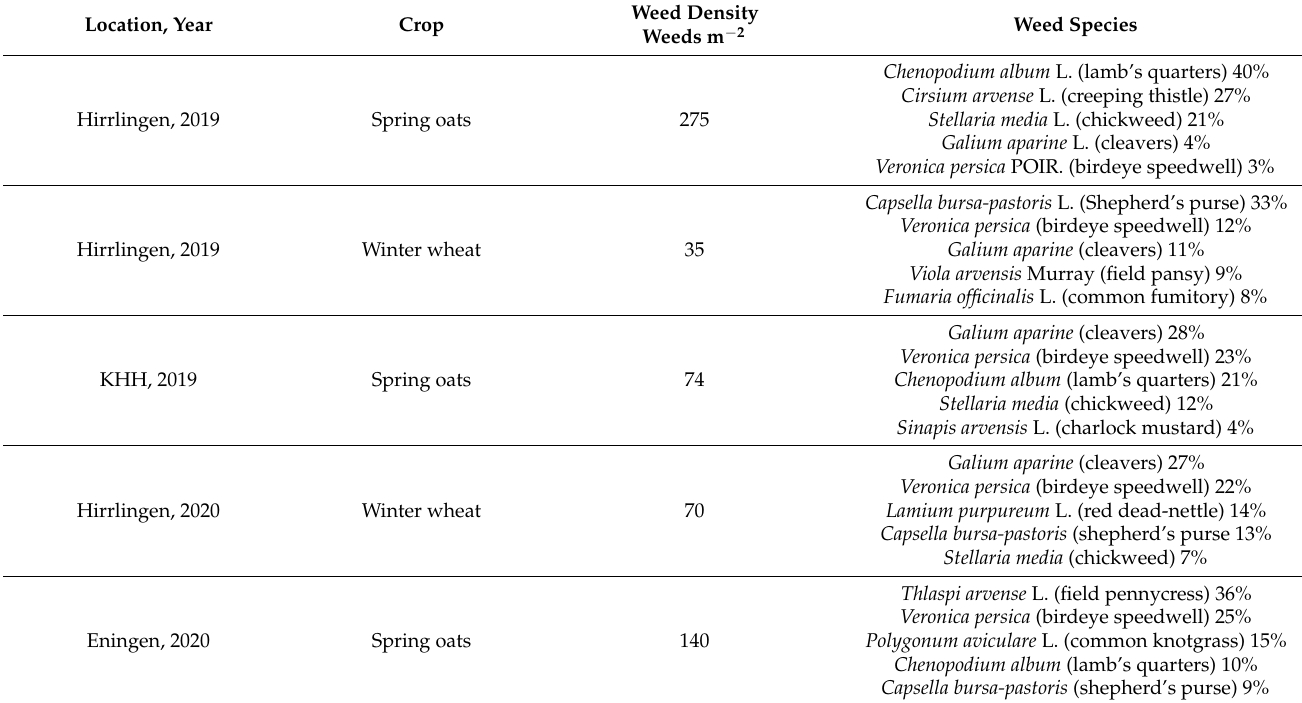
Table 3. Average weed density (weeds m − 2 ) and the dominance of the five most abundant weed species (%) in the trials in Hirrlingen, KHH, and Eningen in 2019 and